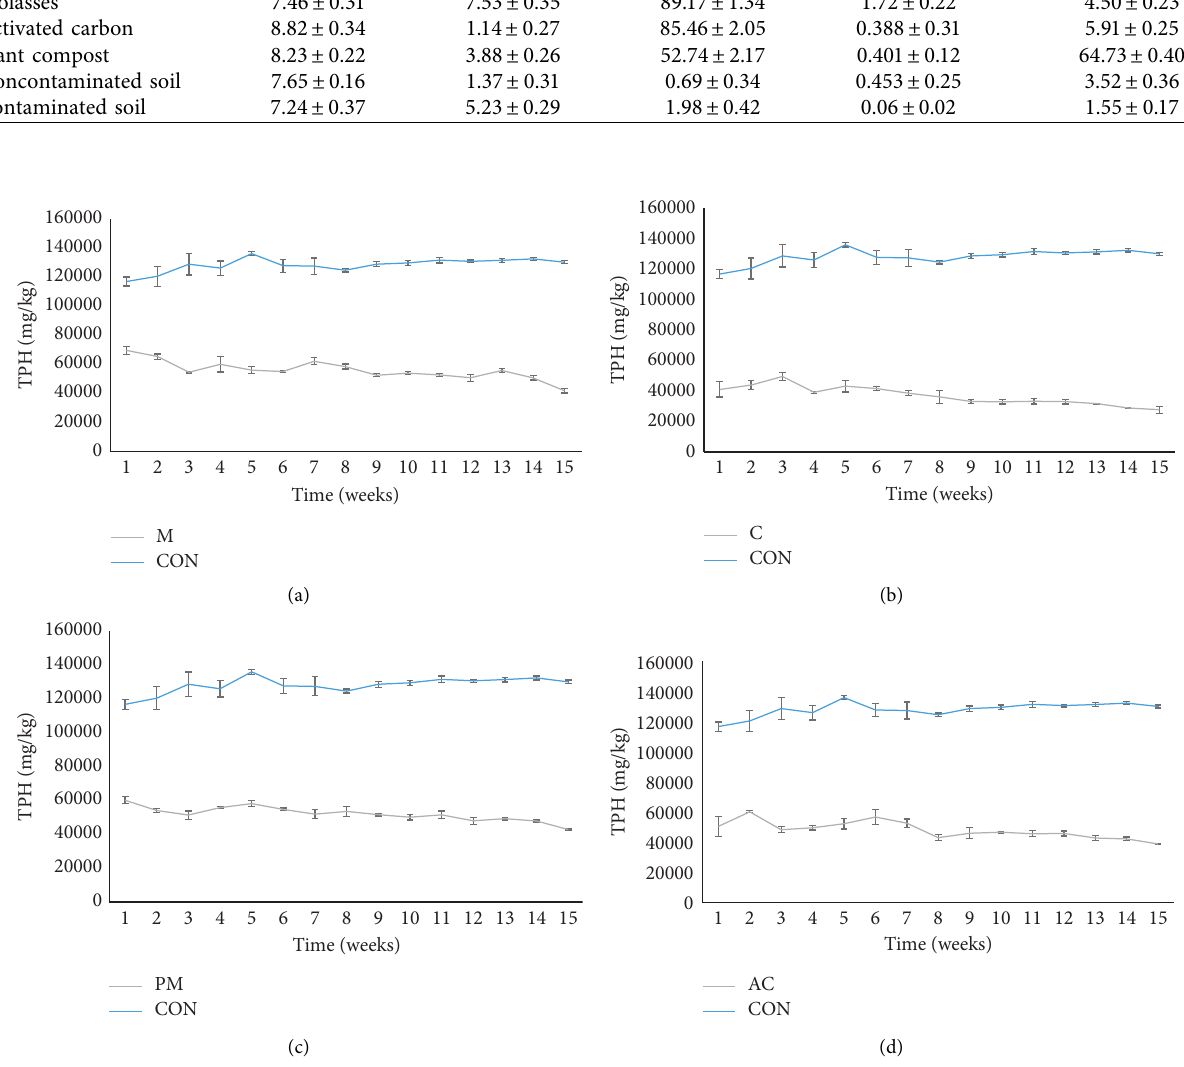
Figure 1: TPH disappearance from oil-contaminated soil as a function of amendment type; (a) molasses vs. control; (b) compost vs. control; (c) papermill sludge vs. control; and (d) activated carbon vs. control. M: molasses; C: plant compost; PM: papermill sludge; AC: activated carbon; and CON: control. All TPH data for the amended soils were significantly different ( p < 0.05) from the control treatment at all sampling